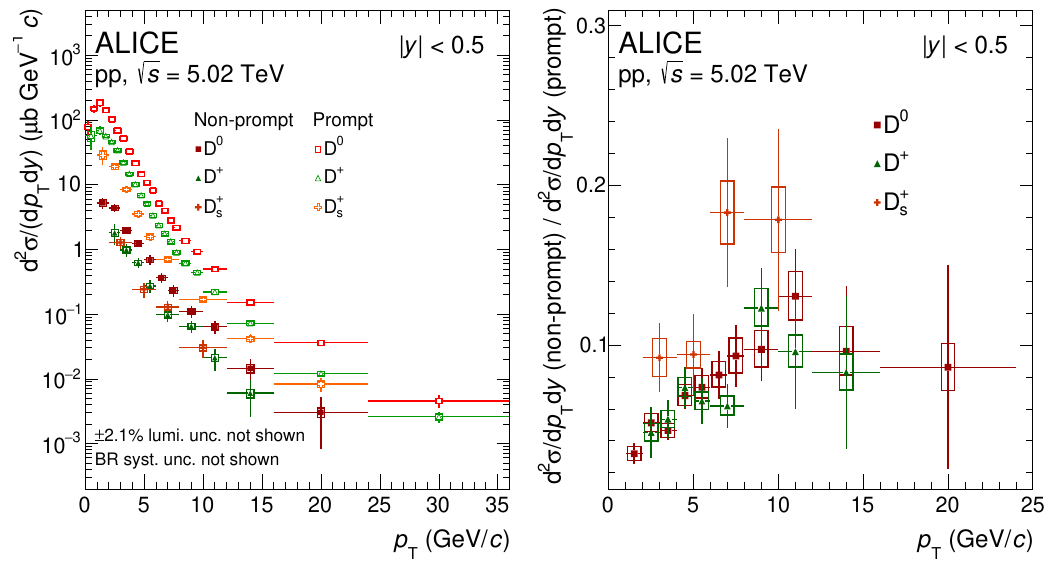
Figure 6 . Left: p T -differential production cross sections of prompt and non-prompt D 0 , D + , and √ D + mesons in pp collisions at s = 5 . 02 TeV . The measurement of prompt D 0 mesons is the one s reported in ref. [3], with updated decay BR as discussed in the text. Right: ratios of p T -differential production cross sections of non-prompt and prompt D 0 , D + , and D + mesons. Statistical (vertical s bars) and systematic uncertainties (boxes) are shown. The symbols are positioned horizontally at the centre of each p T interval, with the horizontal bars representing the width of the p T interval.